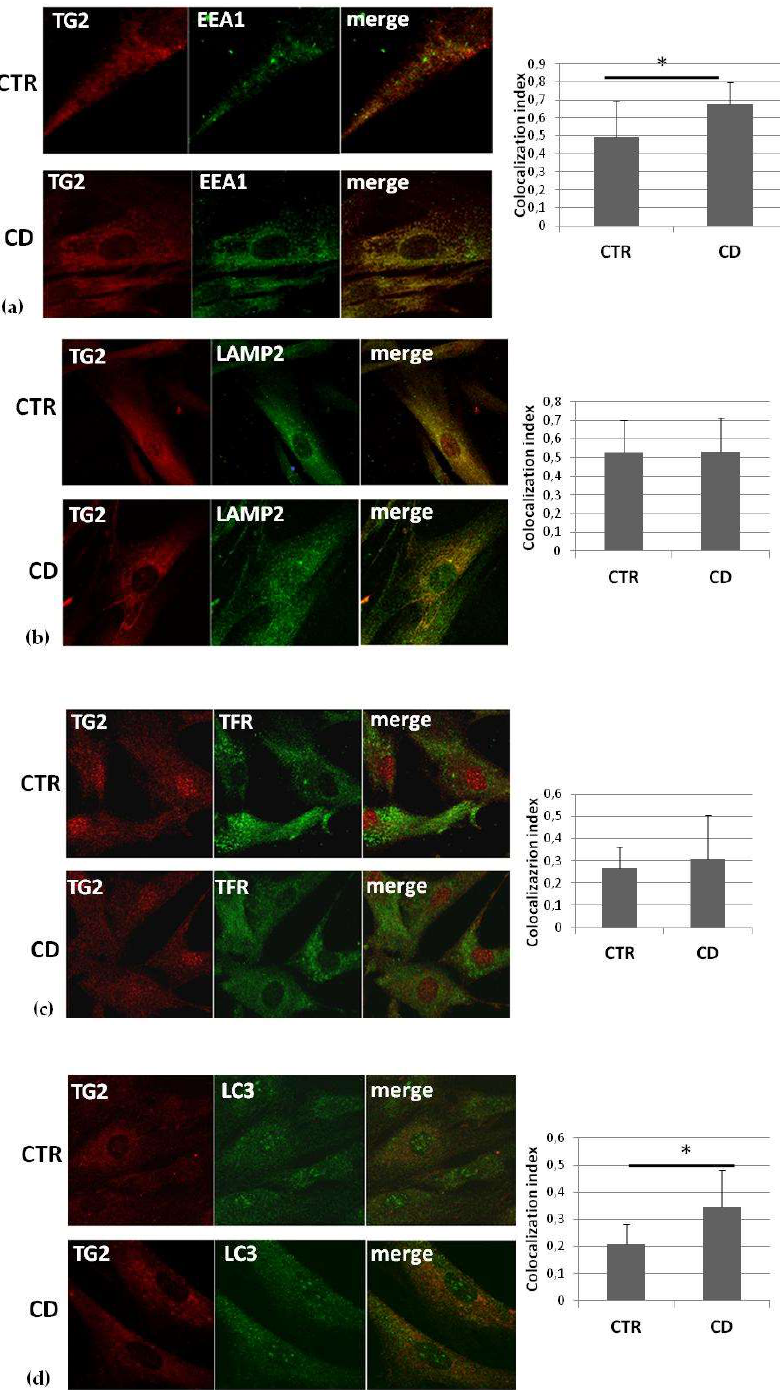
Figure 4. TG2 colocalization with endosomal markers. Confocal immunofluorescence images (magnification 63 × ) of fibroblasts from control and CD subjects stained with antibodies against TG2 (red) and EEA1 (green) ( a ) , LAMP2 (green) ( b ), transferrin receptor (TFR) (green) ( c ), and LC3 ( d ); the merging of red and green fields is shown in yellow. Graphs resume colocalization data regarding experiments on four control and four CD samples. Asterisk (*) indicates that p is < 0.05.